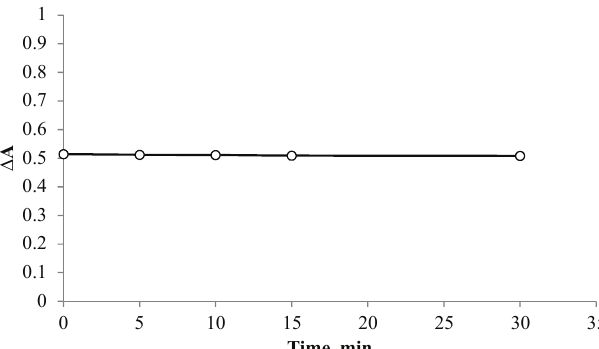
Fig. 3. Graph of the dependence of the absorbance of the reaction product of metoprolol tartrate with BPB in methanol solution depending on time